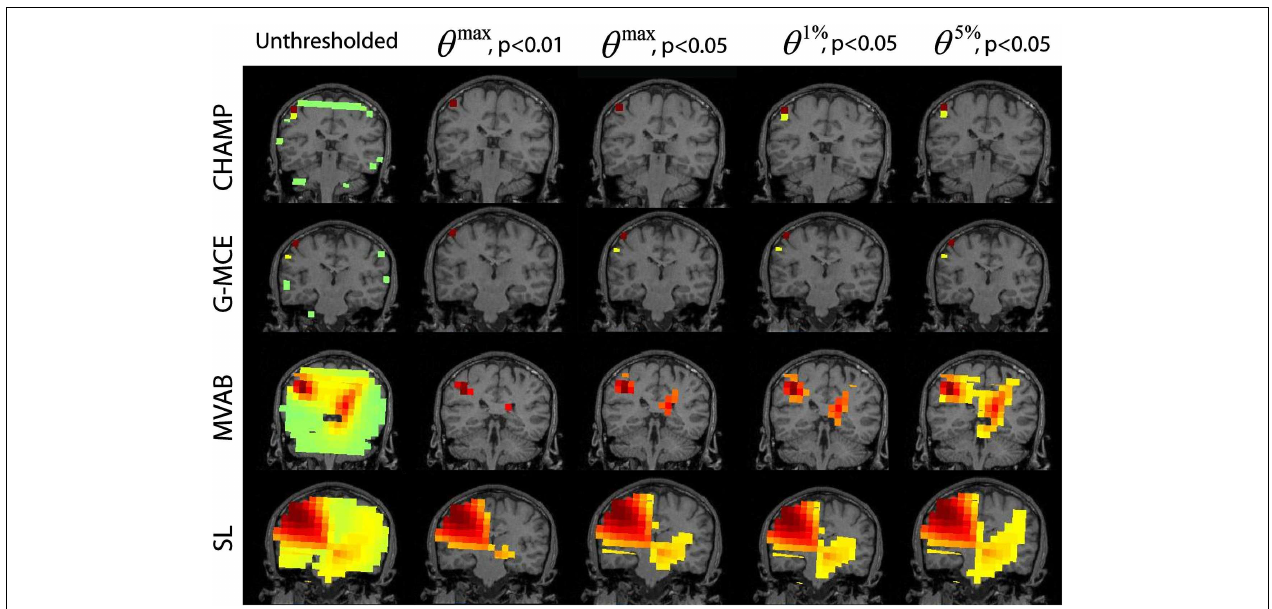
(coronal slice).The power is thresholded with the maximal statistic: θ max , p < 0.01 and 0.05 and with the alternative to the maximal statistic thresholds: θ 1% , p < 0.05, and θ 5% , p <